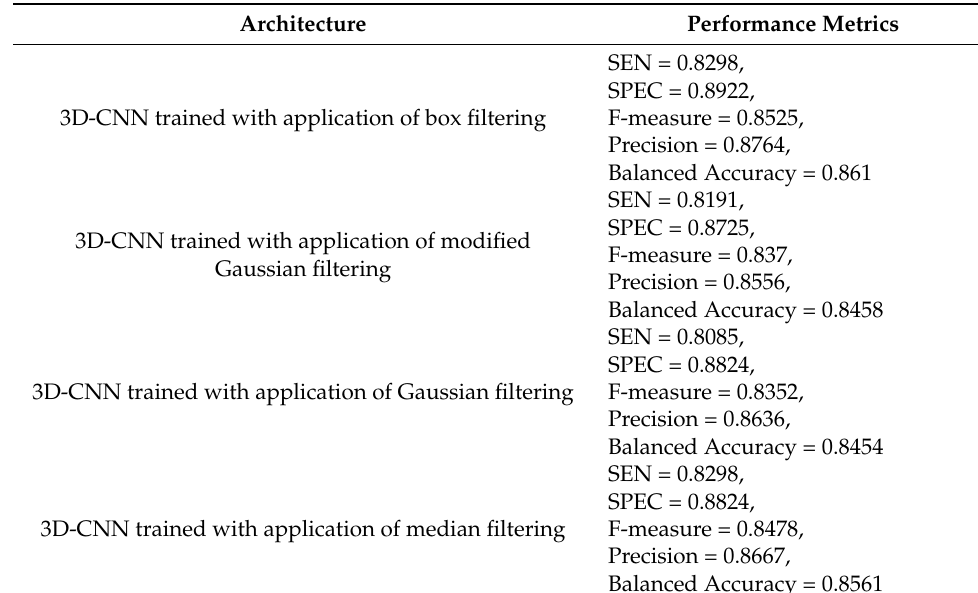
Table 4. Result of binary classification between AD and NC classes.